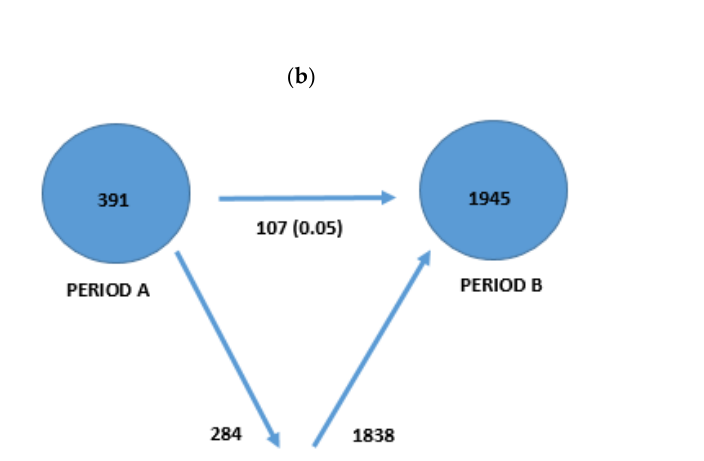
Figure 8. Network by co-occurrence; ML; Period to 2015. Period from 2016 In the period since 2016, more categories have emerged around ML applied to the military world. As we can see in Figure 9, there are different areas that can be divided into five categories.